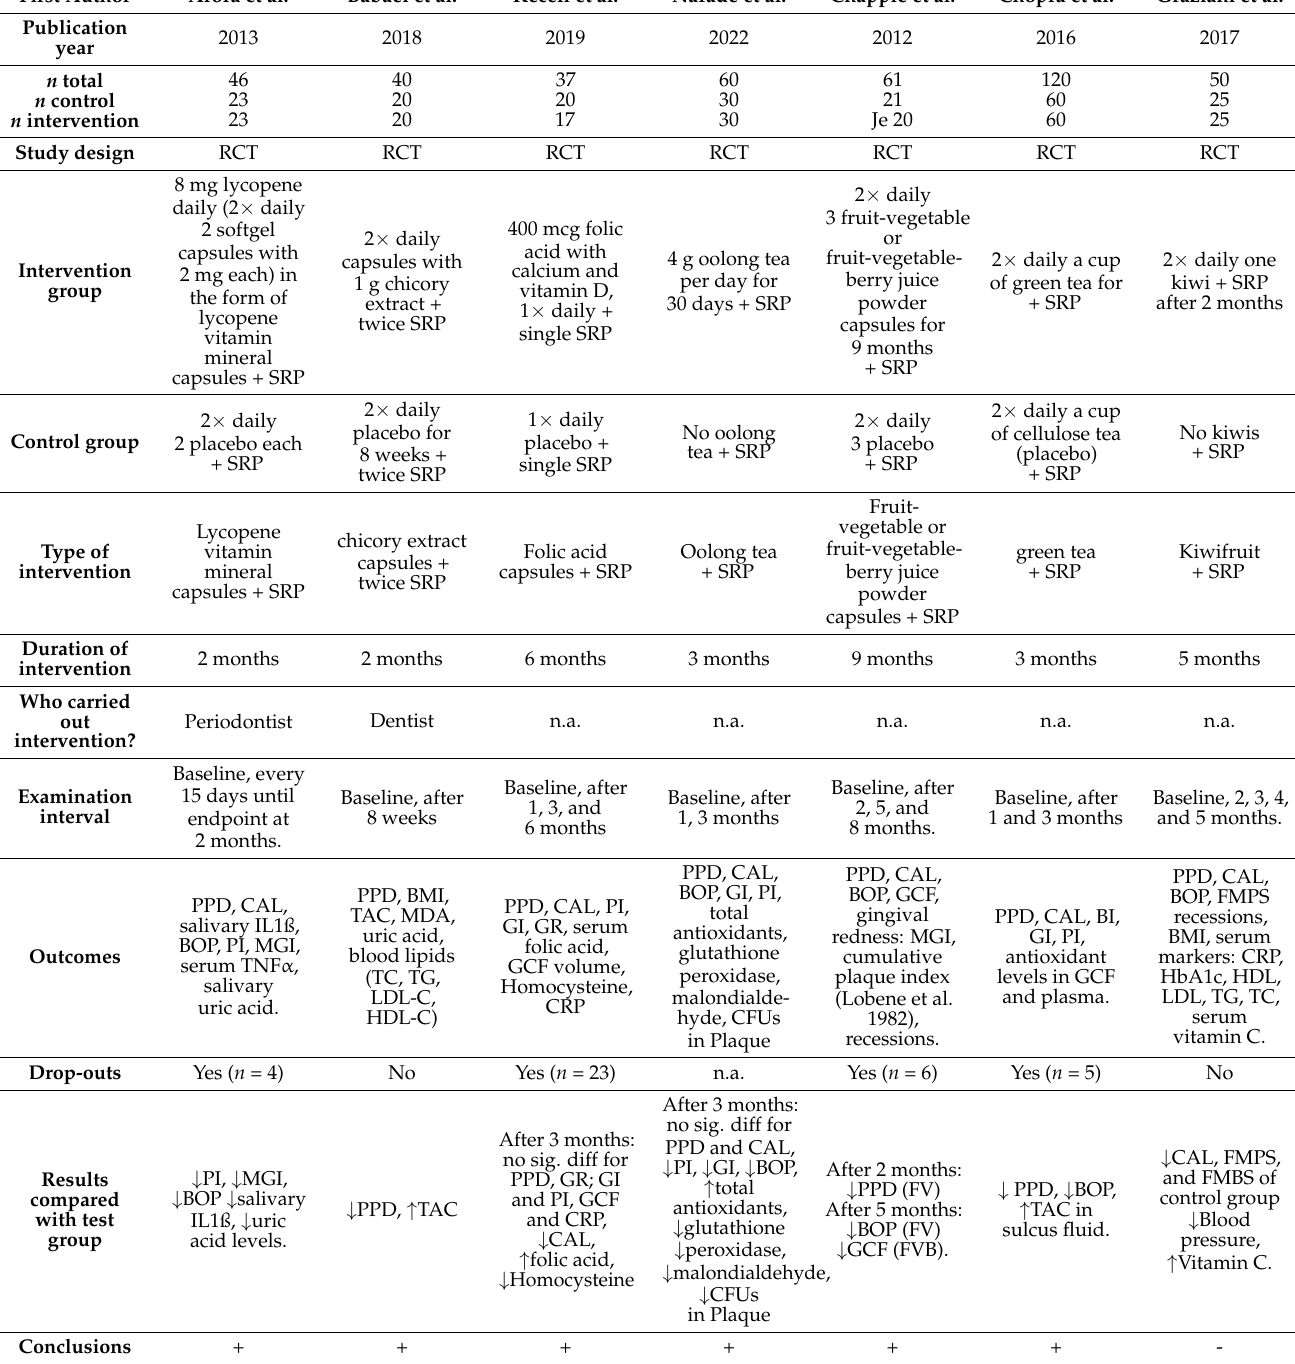
Table 1. Characteristics of the included